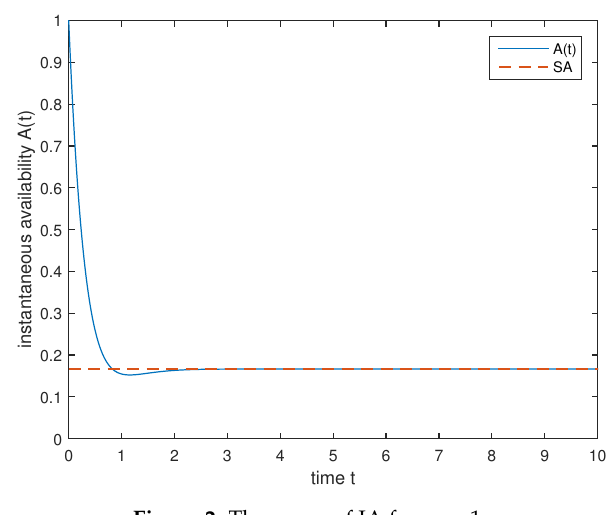
Figure 2. The curve of IA for case 1.